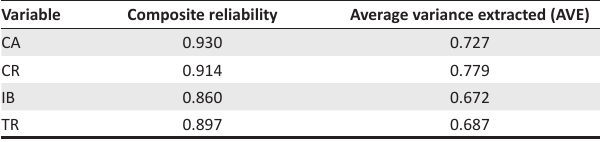
TABLE 1: Results of construct reliability and validity. Variable Composite reliability